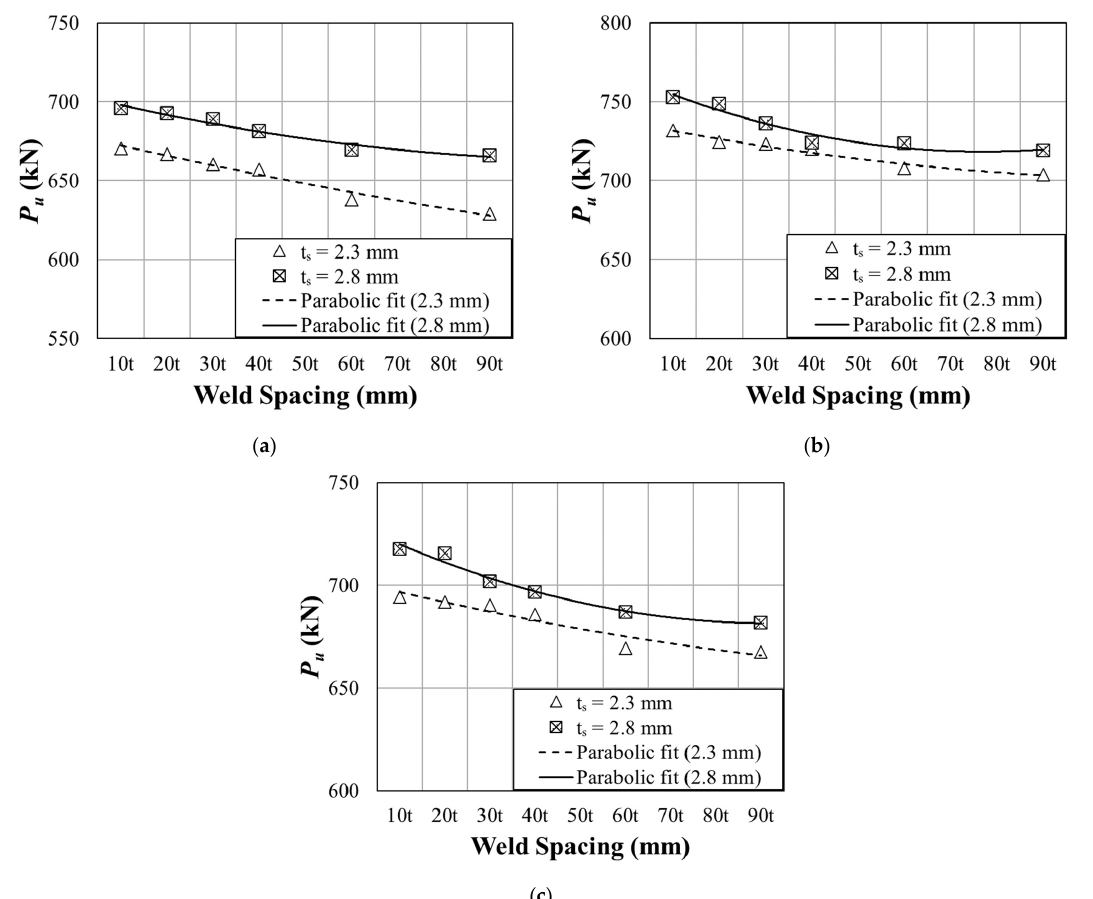
Figure 20. The effect of different stiffener thicknesses on the performance of the circular CFDST . ( a ) b s = 12 mm, ( b ) b s = 18 mm, ( c ) b s = 25 mm.